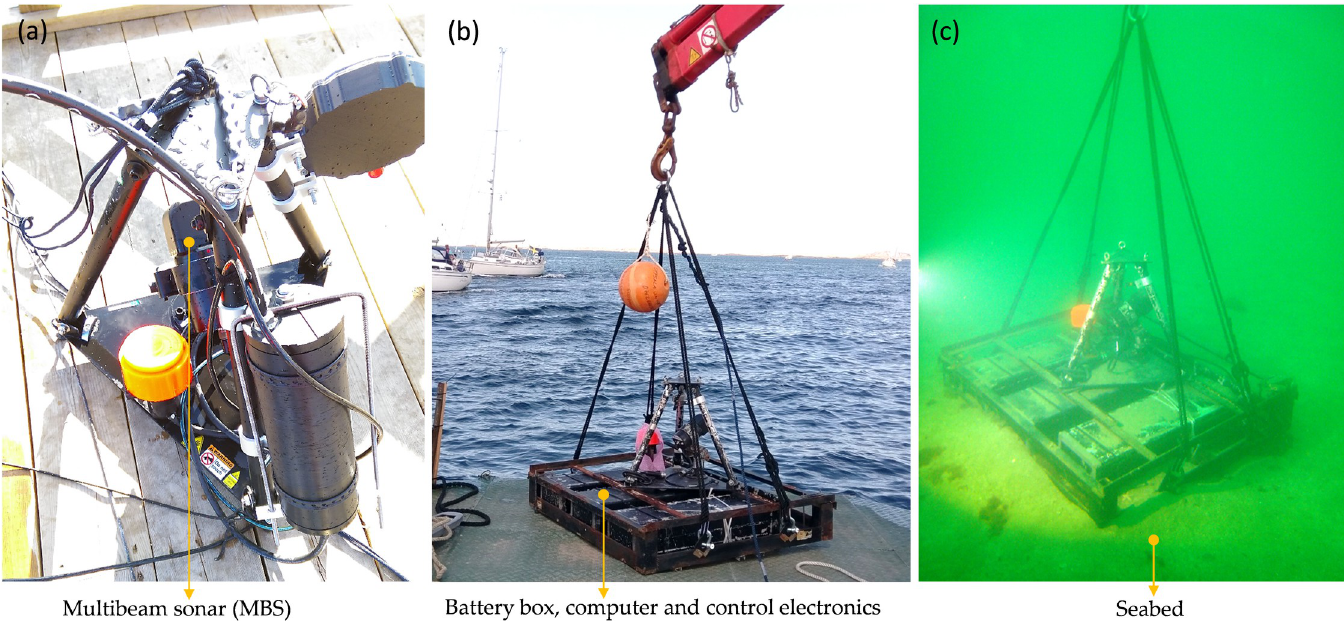
Fig 3. Lateral view-scheme to facilitate the interpretation of the acquired multibeam data and the resultant acoustic images. The multibeam sonar (MBS) was located at 24.3 m of depth at a distance of 30 m and 50 m from WECs A and B respectively. The field of view (FOV) opens in 20˚ vertically and 130˚ horizontally. The MBS pitch angle ( α MBS) was set to